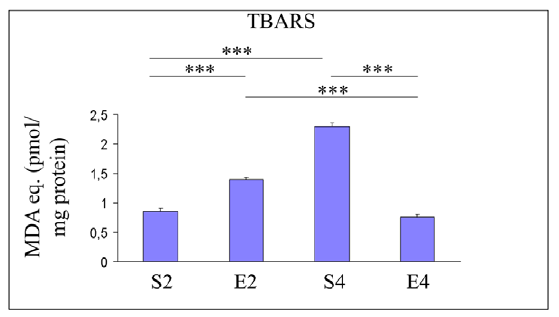
Figure 2. Hippocampal peroxidative damage in mice undergo- ing 2- or 4-mo moderate treadmill running. Assessment of hippocampal levels of thiobarbituric acid-reactive substances (TBARS) levels in mature CD-1 female mice undergoing a two- or four-month moderate and regular treadmill-based exercise program (E2 or E4, respectively); age-matched sedentary animals (S2, S4) were used as controls (n=12 per group). TBARS levels were found to be increased by the sedentary aging (S4 vs S2). 2-mo exercise increased TBARS hippocampal concentrations (E2 vs S2), while 4-mo running decreased TBARS levels (E4 vs S4). Values were given as means 6 std. dev. The level of statistical significance was computed by using two-way ANOVA and post-hoc Newman-Keuls test: *** P , 0.001; Experiments were performed in triplicate.